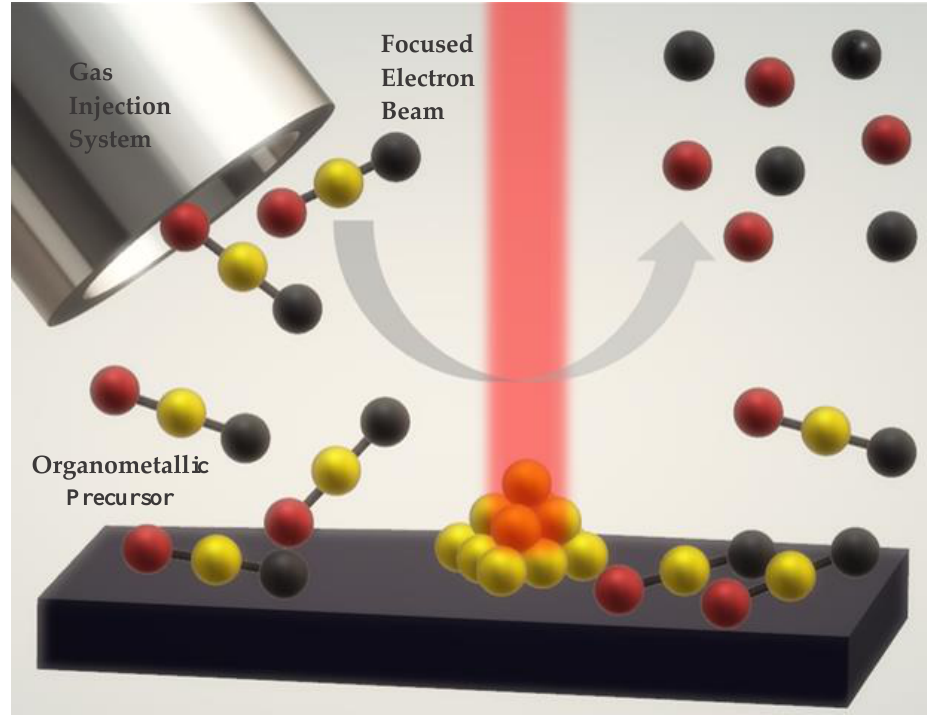
Figure 1. Schematic representation of a nanostructure being deposited by focused electron beam induced deposition (FEBID).